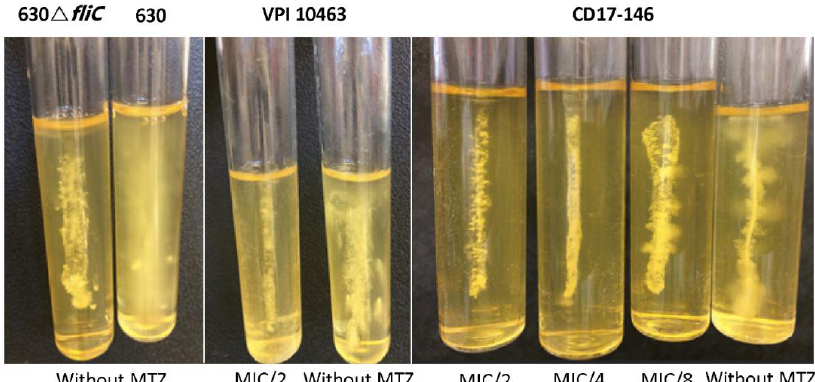
Figure 3. Motility of VPI 10463 (VPI) and CD17-146 (146) at subinhibitory concentrations of MTZ. Bacterial strains were inoculated in BHI medium containing 0.3% agar without or with MTZ at the concentrations 0.125, 0.25 or 0.5 µg/mL and grown anaerobically at 37 °C for 48 h. MTZ reduced the motility of both C. difficile strains through soft agar and this effect is concentration dependent. To test this, C. difficile strains were cultured in the presence or absence of MTZ, and the levels of flagellar gene transcripts were measured by qRT-PCR. In both strains, subin- hibitory concentrations of MTZ reduced the levels of fliC, flgB and fliA mRNAs,